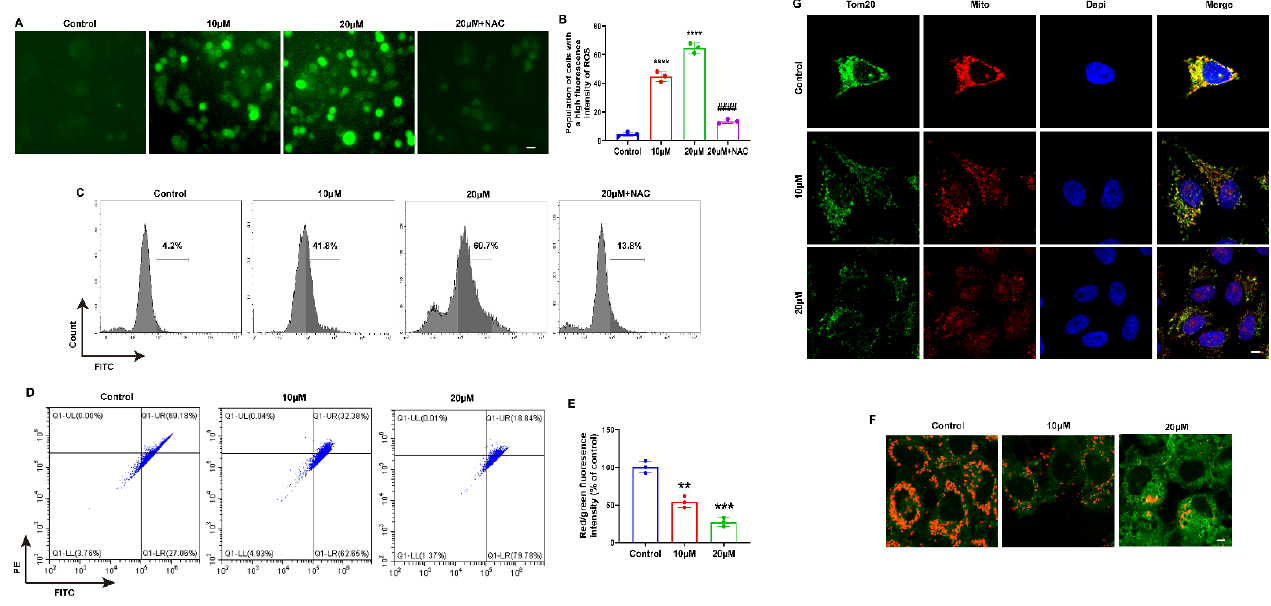
Figure 2. MLD Decreased the Mitochondrial Membrane Potential, Inducing ROS Production in HepG2 Cells. ( A ) DCFH-DA fluorescent probe detected showed that MLD significantly promoted ROS production after 24 h treatment in HepG2 cells. Scale bar: 75 μ m. ( B ) Quantitative analysis of ROS production. ( C ) ROS production measured by flow cytometry. ( D ) The JC-1 fluorescence intensity was measured by flow cytometry. ( E ) Statistical results of the ratio of red and green fluorescence in HepG2 cells treated with MLD for 24 h. ( F ) Fluorescence photographs of mitochondrial membrane potential in HepG2 cells. Scale bar: 25 μ m. ( G ) Fluorescence photographs of mitochondrial membrane protein TOM20 in HepG2 cells. Scale bar: 25 μ m. The results are representative of three independent experiments and are expressed as the mean ± SD. ** p < 0.01, *** p < 0.001, and **** p < 0.0001 compared with the control group. #### p < 0.0001 compared with MLD (20 μ M) group.